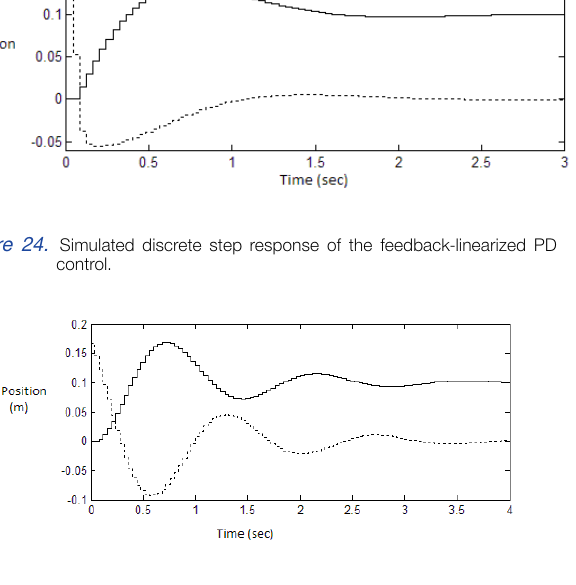
Figure 26: Step response of linear P‐D controller using filtered derivative